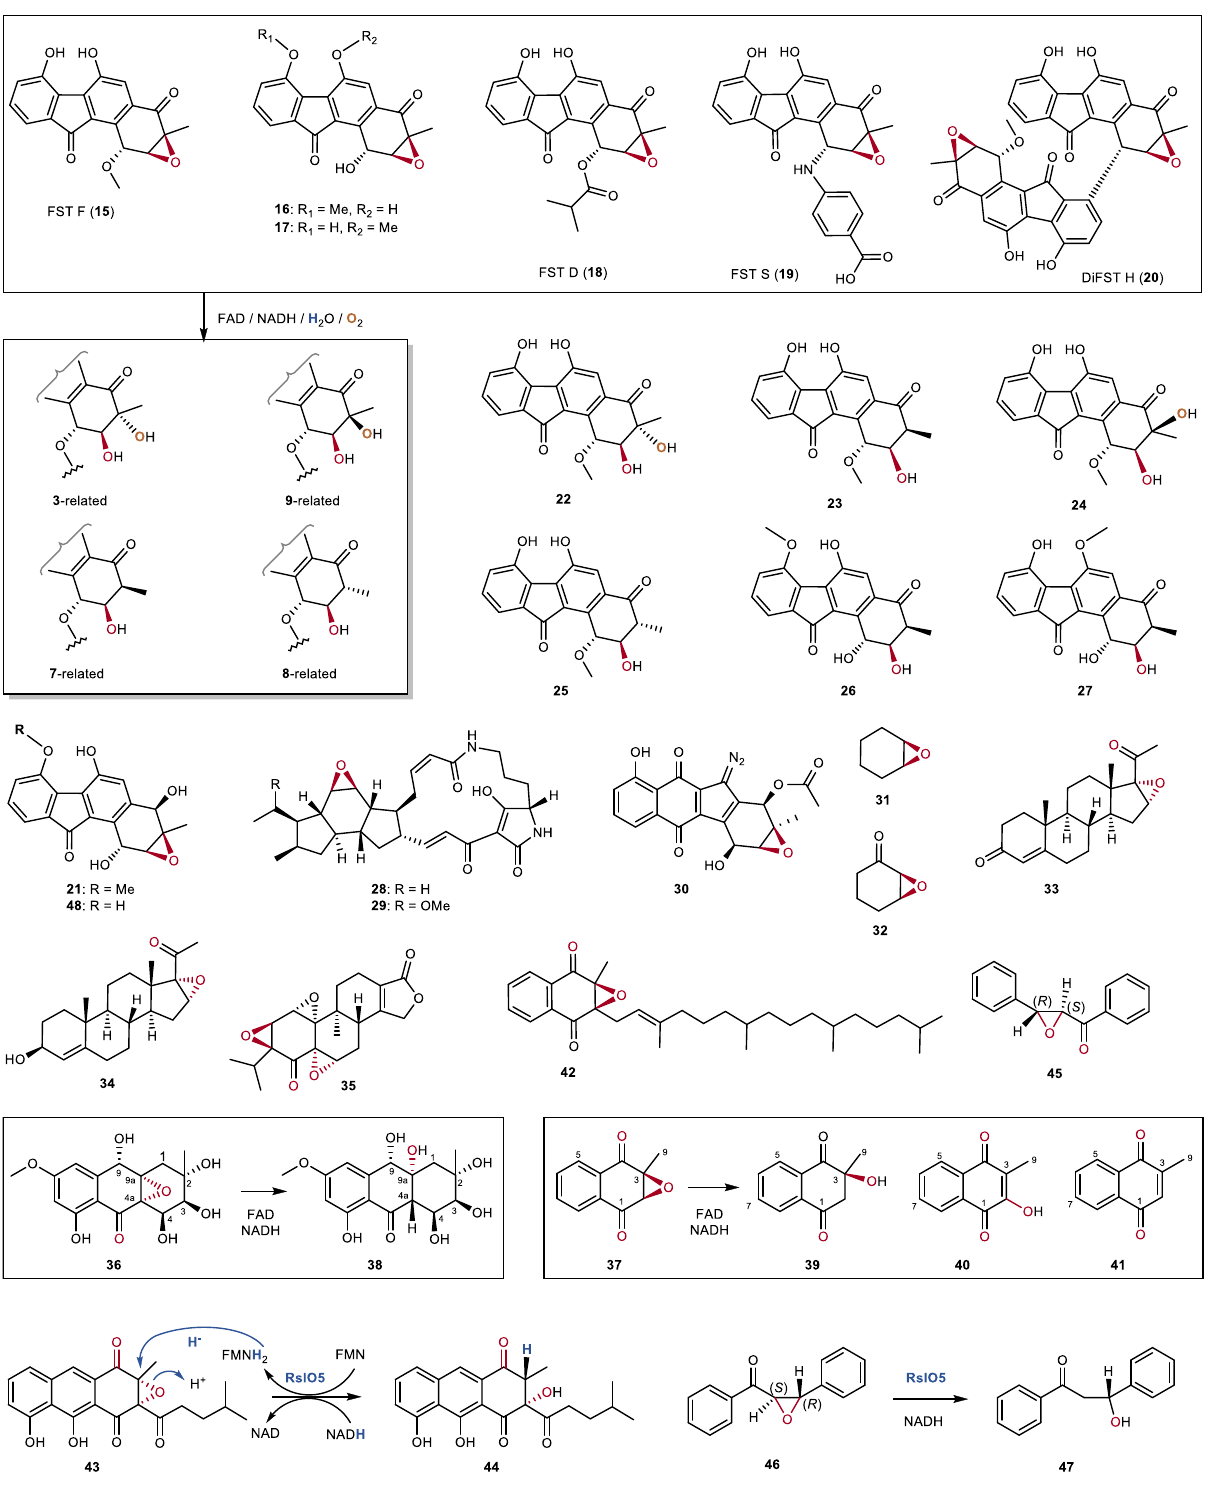
Fig. 4 | Expanded substrate and product pro fi le for the FAD/NADH-mediated epoxide ring opening reactions and comparison with the fl avoenzyme RslO5- catalyzed reactions. FST derivatives 15 ‒ 20 could undergo epoxide-ring opening reactionsupontreatmentwithFAD/NADHtoproducemultipleproductsrelatedto 3 , 7 , 8 , and 9 . FST Q ( 21 ) was unreactive with FAD/NADH. The epoxides 28 – 35 displayed no activities with FAD/NADH. Treatment of auxarthrol H ( 36 ) or